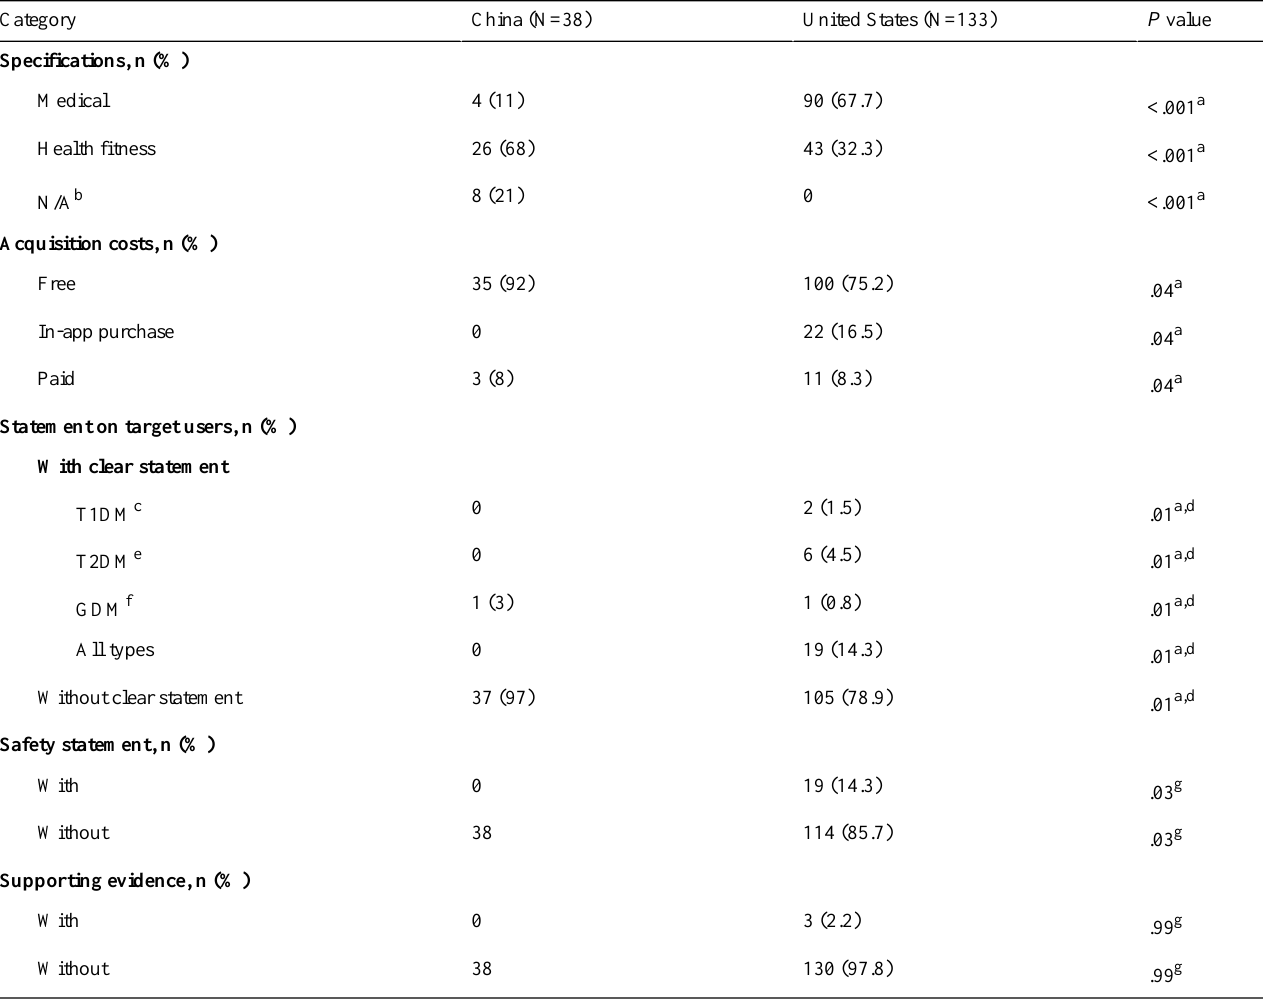
Table 1. Metadata of in-store mobile apps for diabetes self-management between the United States and